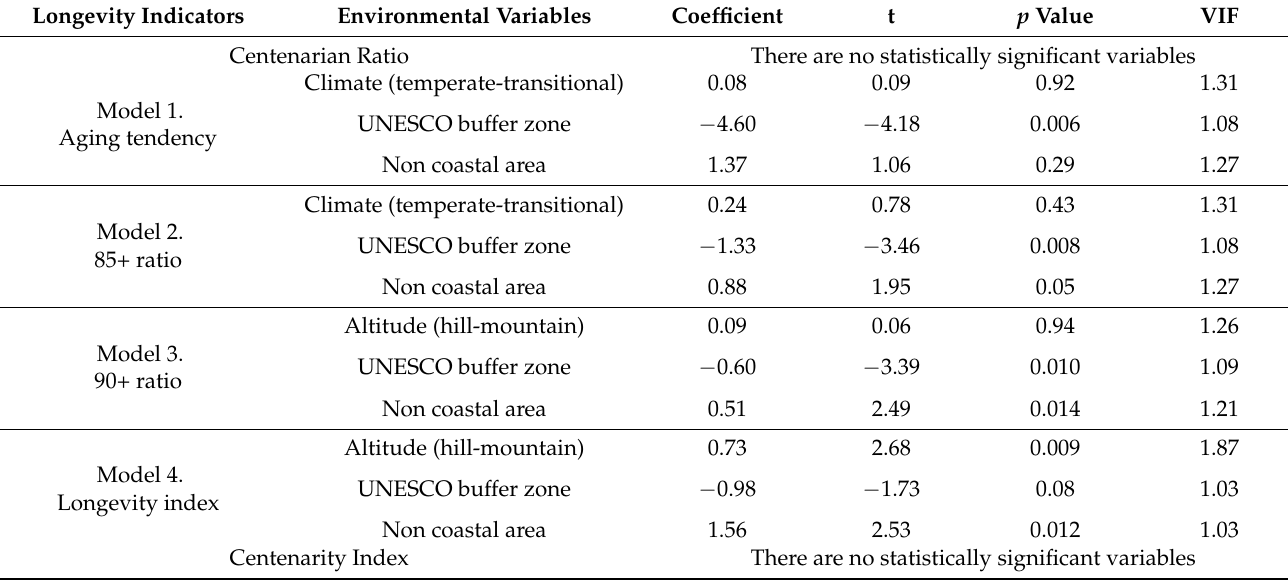
Table 4. Results of OLS regression and values of the Variance inflation factor